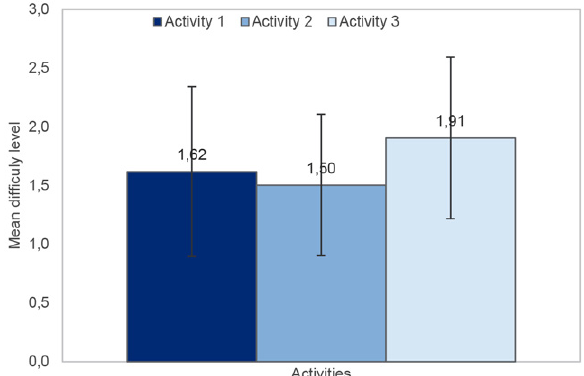
Figure 7 : Step difficulty mean with SD (whiskers) by activity (1 = no difficulties, 5 = severe difficulties)